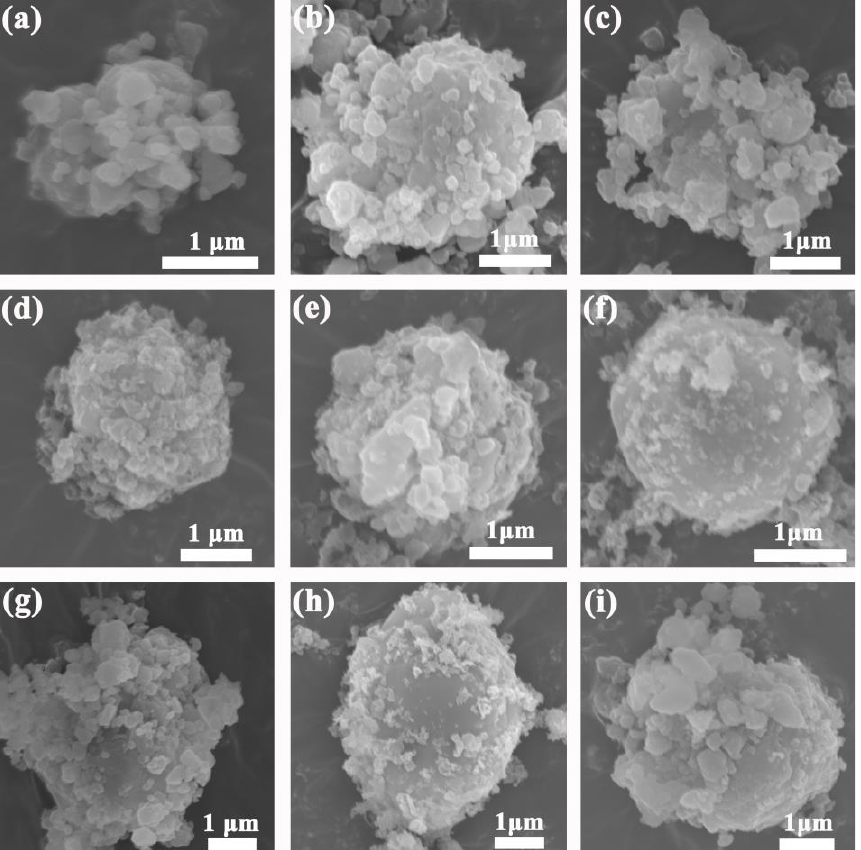
Figure 7. The SEM images of the state of ball milling ( a ); after hydrogen release ( b ); and after re- hydrogen ( c ) of MgH 2 -2.5 wt% ZnO; the images of SEM of the state of ball milling ( d ); after hydrogen release ( e ); and after re-hydrogen ( f ) of MgH 2 -5 wt% ZnO; the images of SEM of the state of ball milling ( g ); after hydrogen release ( h ); and after re-hydrogen ( i ) of MgH 2 -7.5 wt% ZnO.